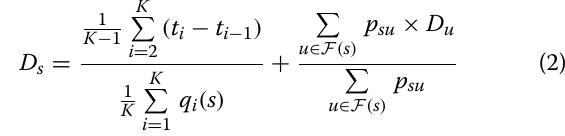
with Eq. (1). For sender s , if there is only one available for- warder u at time t i , Eq. (1) will be reduced to q i ( s ) = p su